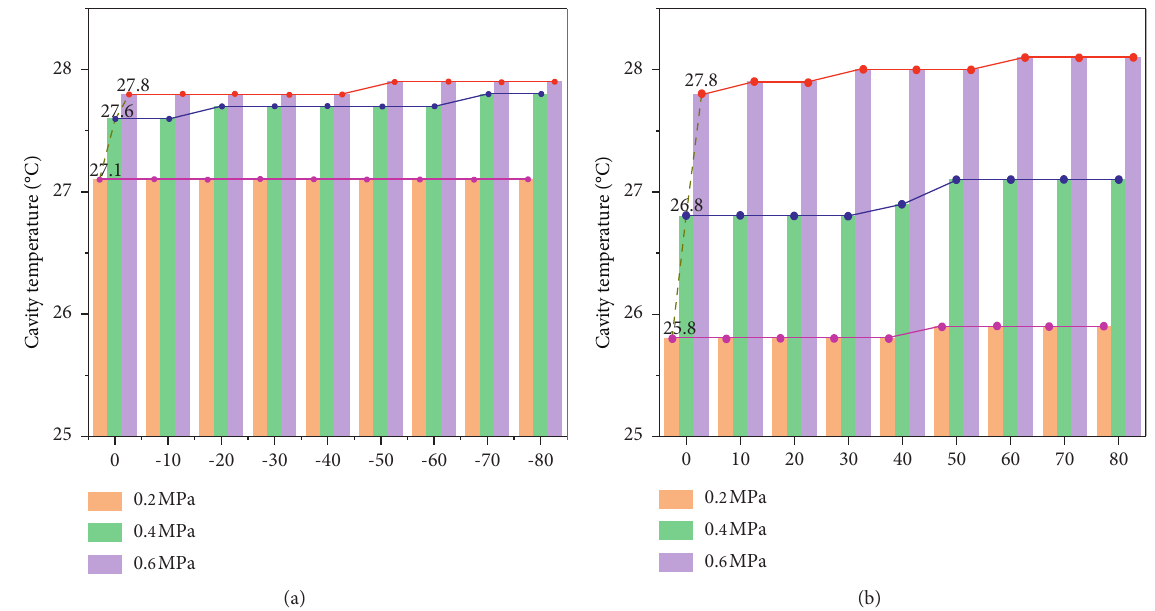
Figure 5: Airbag chamber temperature change results: (a) tension and (b)